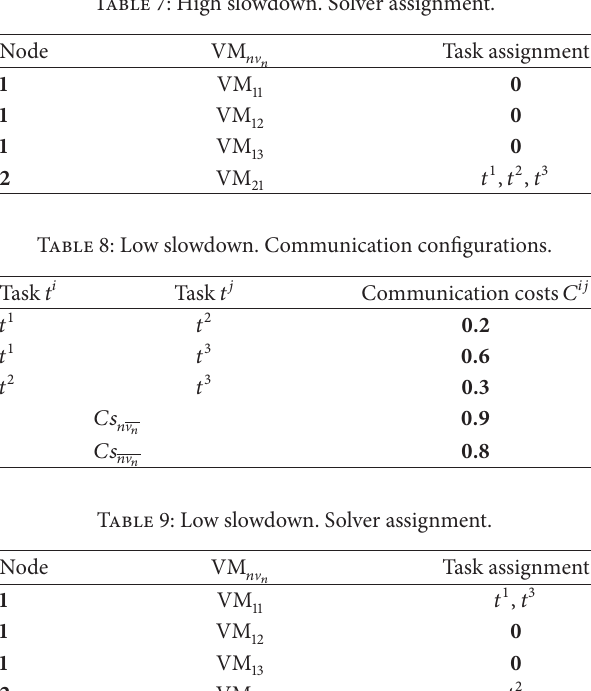
Table 10: Moderate slowdown. Communication configurations.